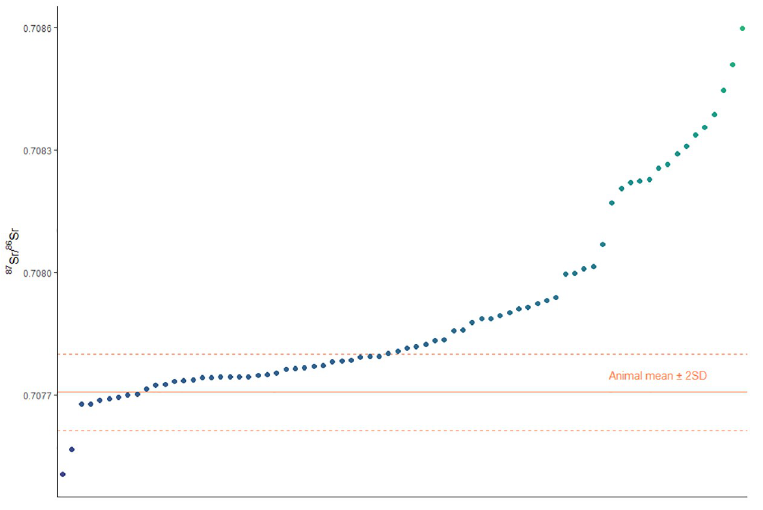
Fig 4. 87 Sr/ 86 Sr values of all individuals from the archaeological site of Tell el-Dab c a.